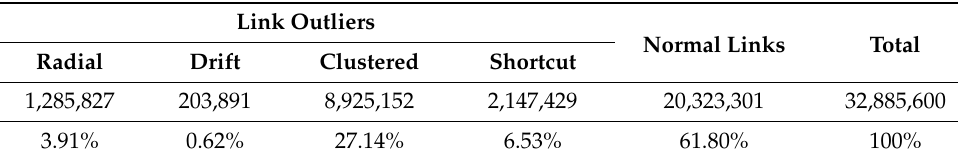
Table 1. Tracking link statistics.